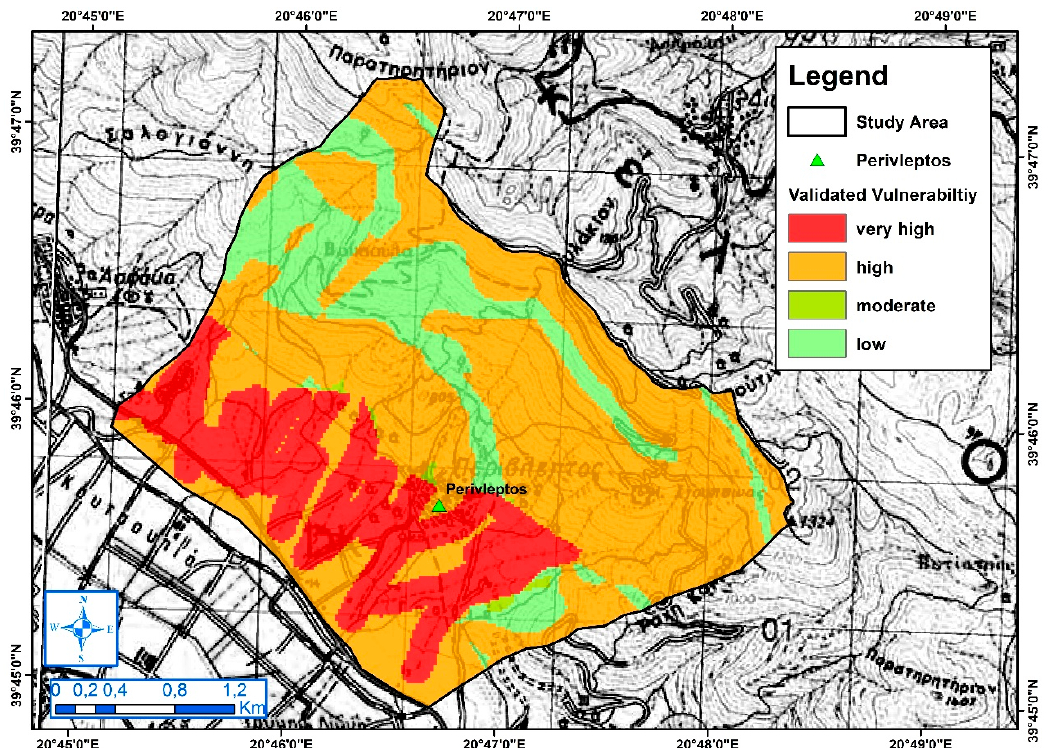
Figure 7. Validated vulnerability map of the study area.